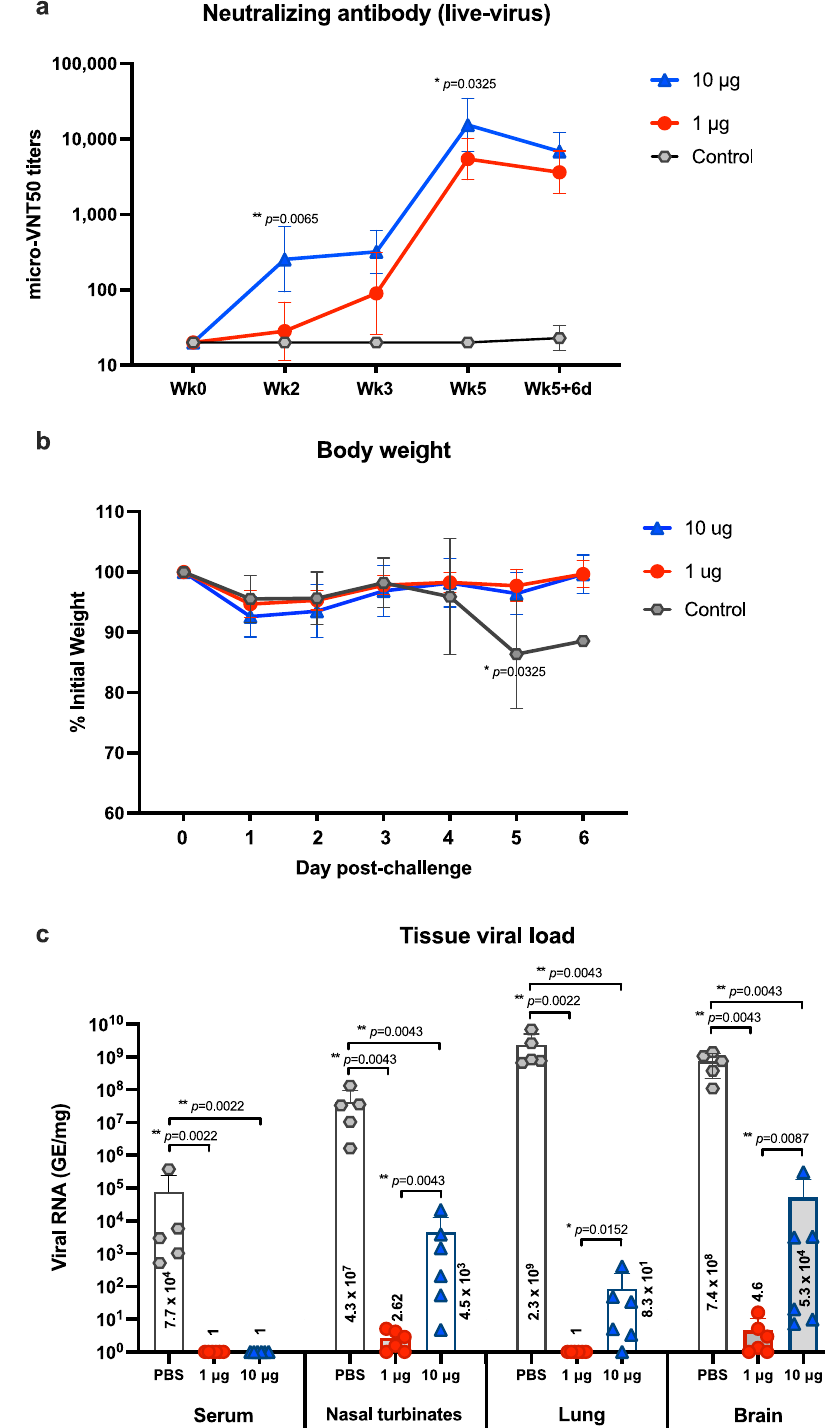
Fig.6|Immuneresponseandprotectiveef fi cacyresultsinthechallengestudy. a Kinetic response of micro-VNT50 titer after ChulaCov19 immunization and after challenge. The titers were determined in duplicate assays from control ( n =5) or vaccinatedgroups(n=6),respectively.DataarepresentedasGMTofmicro-VNT50 titerwith95%con fi dentinterval.Statisticalanalysiswasperformed tocomparethe GMT of micro-VNT50 between 1 and 10 μ g dosed mice at each time point. b Body- weight values with SD are presented as a percentage of initial body weight before challenge (Day 0) through Day 6 post-challenge. In the control group, 3 out of 5